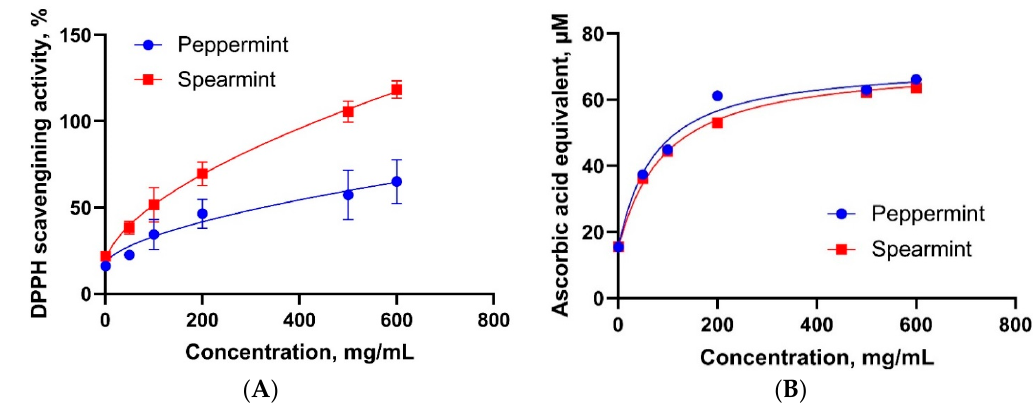
Figure 4. Dose response of peppermint and spearmint oils using chemical-based antioxidant capacity assays. ( A ) 2,2- diphenyl-1-picrylhydrazyl (DPPH) radical scavenging activity assay and ( B ) reducing power assay. Data are presented as the mean of 6